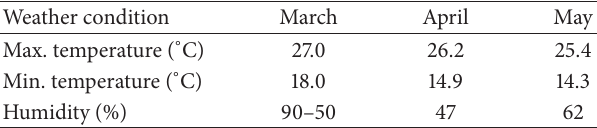
Table 1: Weather conditions for collection months